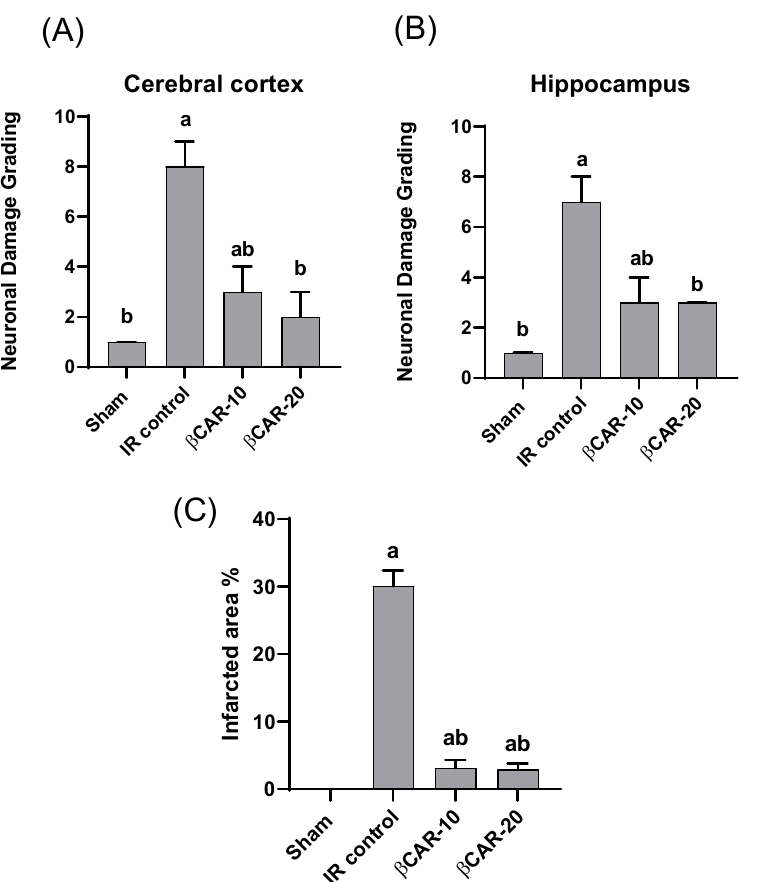
Figure 5. Effect of beta -carotene on ischemic neuronal grading and infarcted area %. ( A ) Ischemic neuronal grading in cerebral cortex. ( B ) Ischemic neuronal grading in hippocampus, n = 6, values expressed as median with interquartile changes, a, b denotes significant difference from sham and I/R control groups, respectively, at p ≤ 0.05. ( C ) Effect of beta -carotene on infarcted area % in focal cerebral ischemia-reperfusion model. Infarcted area % represented as ratio of the infarct area to the whole slide area. n = 6, values expressed as mean with interquartile changes, a, b denotes significant difference at p ≤ 0.05 against sham and I/R control groups, respectively.